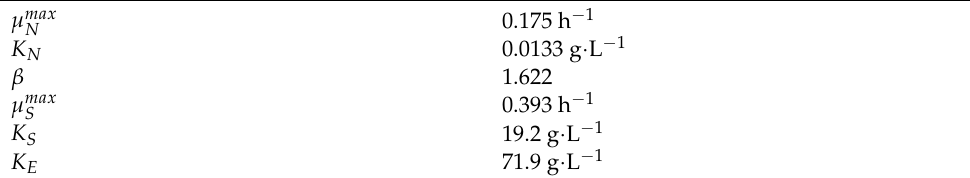
Table 8. Parameters fitted on the experimental